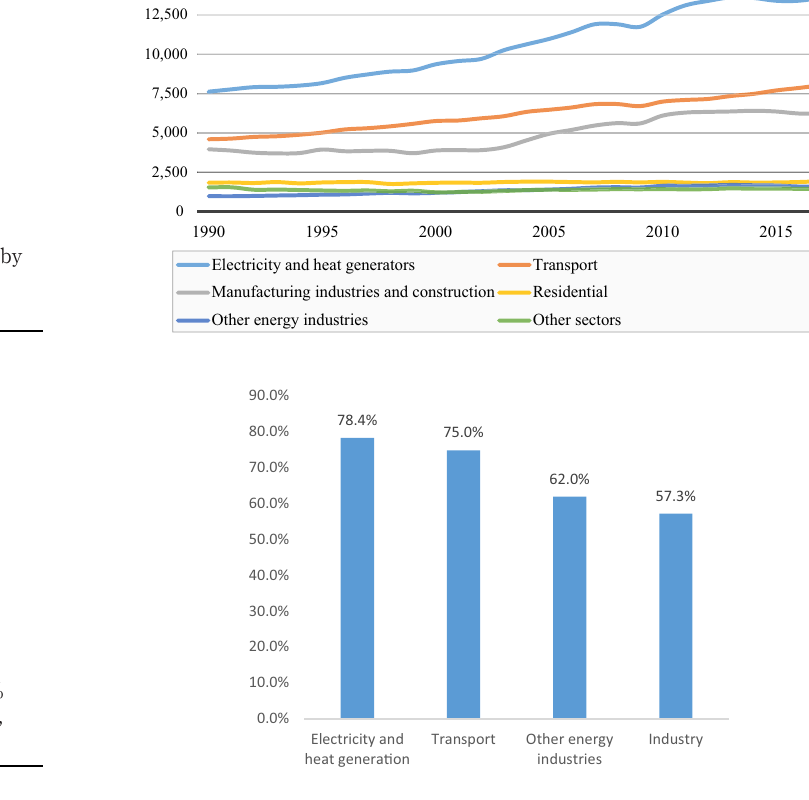
Figure 2. CO2 emissions % change by sector,